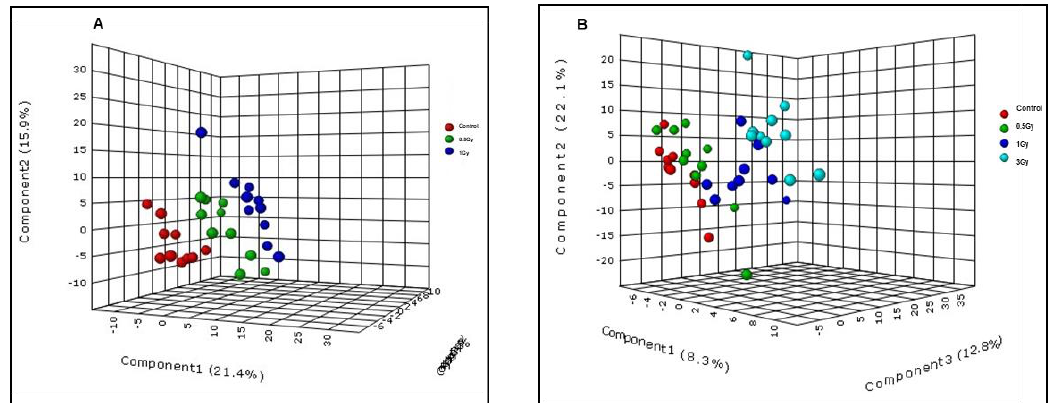
Figure 5. Alterations in mouse plasma metabolite profiles in response to 1 H and γ -irradiation. Panel ( A ): PLS-DA plot showing ANOVA comparison of samples from 0.5 Gy and 1 Gy exposed mice versus control (sham) in response to 1 H irradiation in the negative ionization mode. Panel ( B ): PLS-DA plot showing ANOVA comparison of 0.5 Gy, 1 Gy and 3 Gy-irradiated samples versus control (sham) after exposure to γ -irradiation in the negative ionization mode.